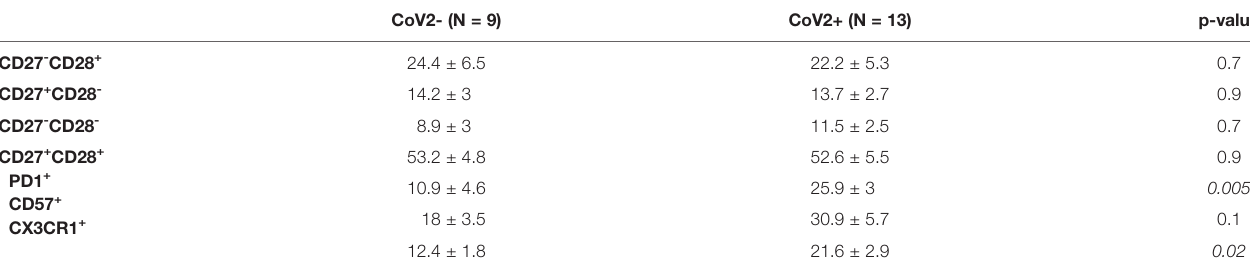
Statistical signi fi cant values are